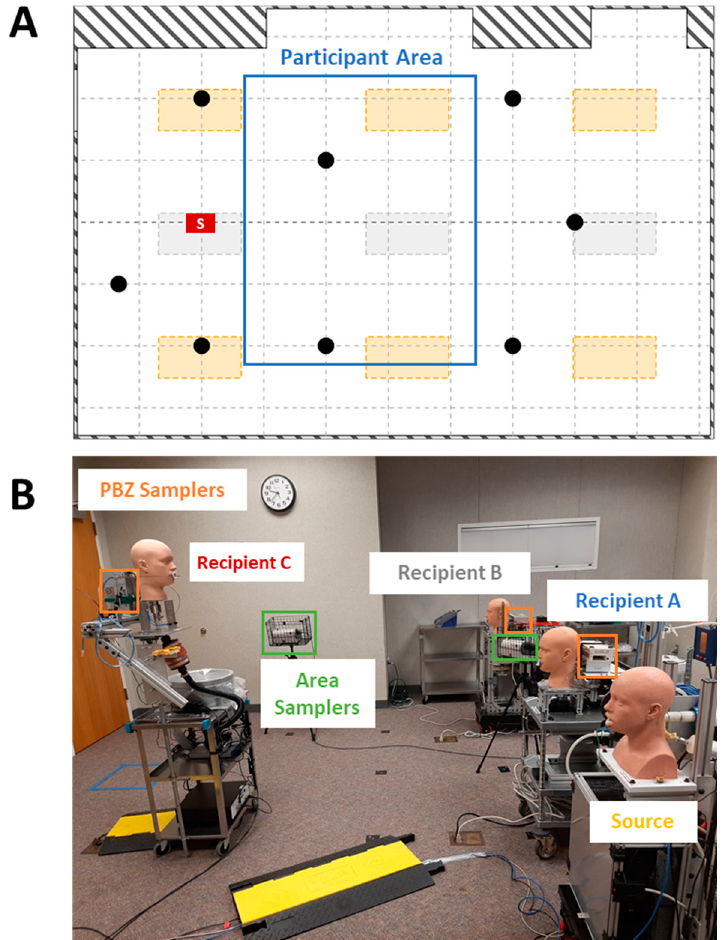
Figure 1. Meeting room. ( A ) Layout of the 6.6 m by 9.1 m meeting room with positions of breathing simulators and optical particle counters relative to the dimensions of the room. The “S” position indicates the position from which an individual addresses the participants. The blue box indicates the participant area in which the breathing simulators were located among all orientations used in this study. Each gridline is evenly spaced 0.9 m. Black dots denote locations of the Model 3330 optical particle counters. The orange rectangles denote the location of the HVAC system supply slot diffusers. Gray rectangles denote the location of the HVAC system return air diffusers. ( B ) Recipient (A and B) and Source simulators positioned 1.8 m from Recipient C which was positioned as the speaker. The personal breathing zone (PBZ) samplers are demarcated in orange and area samplers in green.